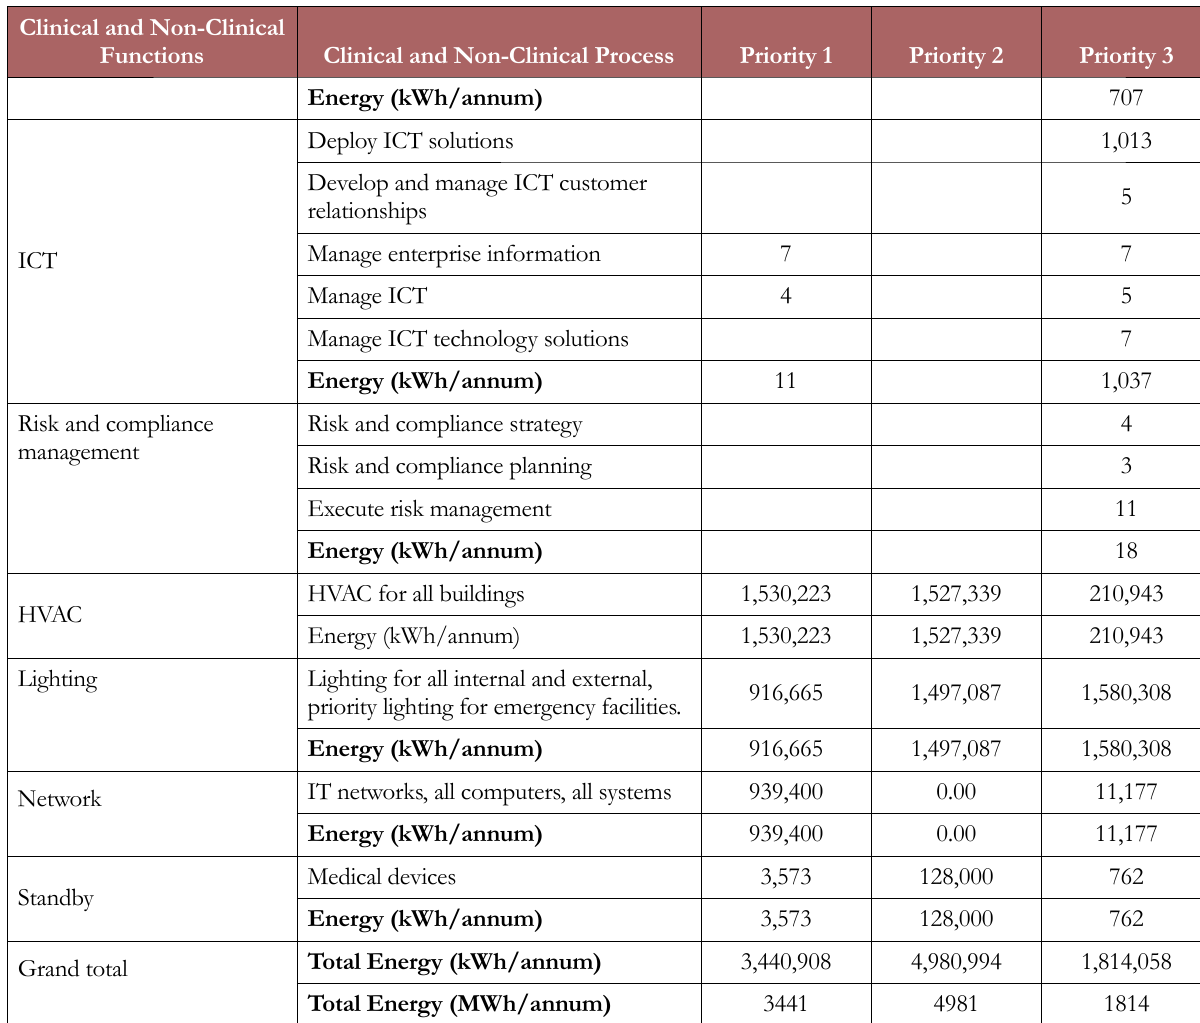
Table 3. Energy demand of clinical and non-clinical operations in a medium-sized hospital, with a 351-bed